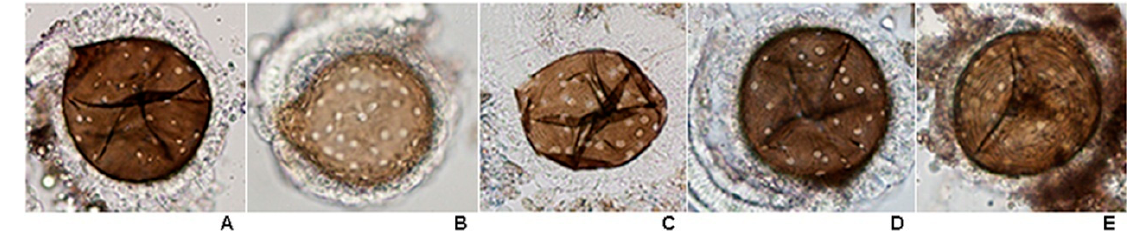
Figure 2. Grading of sperm within spermatheca of inseminated females of the eight species of the Hyrcanus Group: ( A ) 0; ( B ) 1+; ( C ) 2+; ( D ) 3+; and ( E ) 4+ (100× magnification).